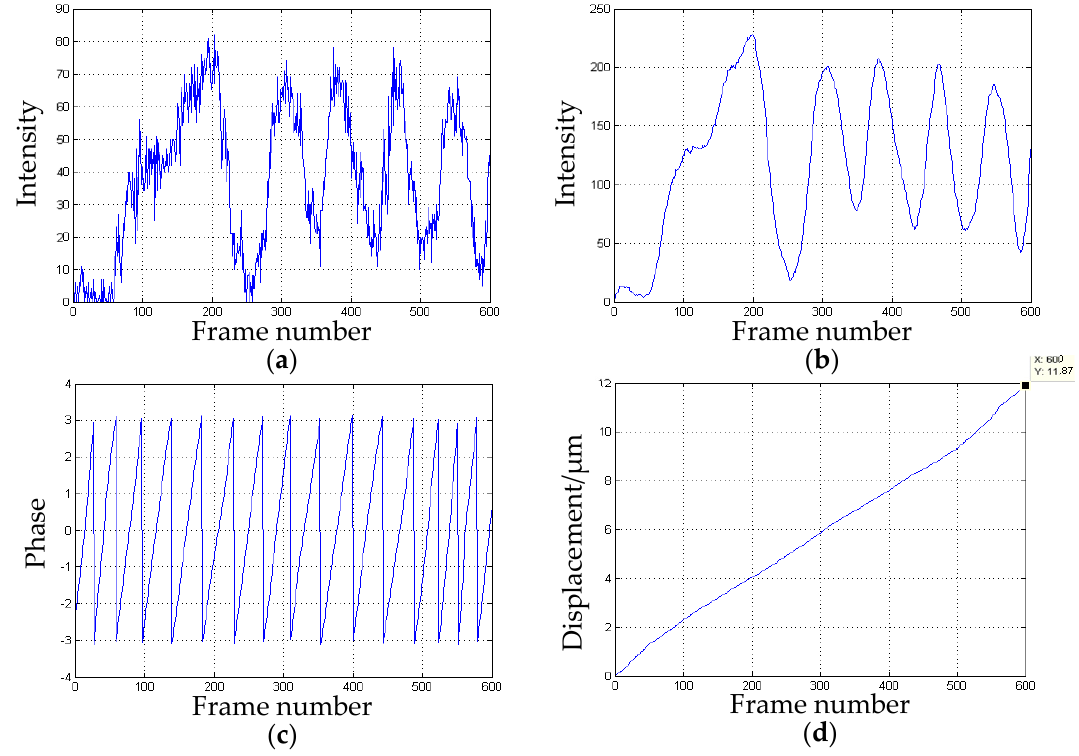
Figure 11. The x -direction displacement: ( a ) the intensity distribution over time; ( b ) the intensity after amplification and smoothing processing; ( c ) the discontinuous phase map obtained by CWT; ( d ) the measured displacement over time.